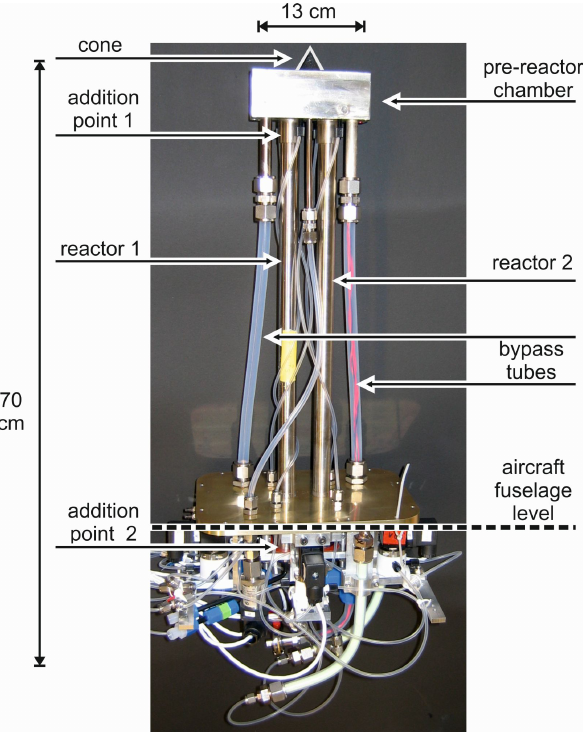
Fig. 3. Side view of the PeRCEAS inlet. Not shown: outer aircraft protection pylon and inner aircraft protection casing.